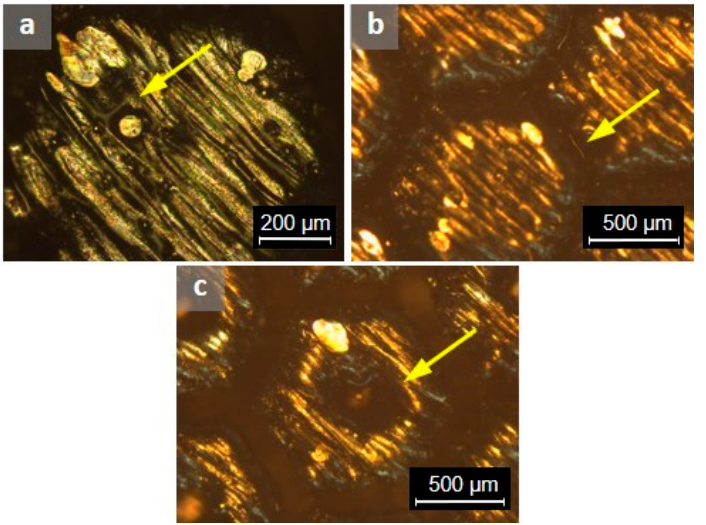
Figure 14. Lubricant traces on samples, after 20,000 laps, R13.5_N5_L lubricated tests; ( a ) traces in between laser scanning tracks, ( b ) traces on the bottom of gaps, ( c ) traces into dimples.